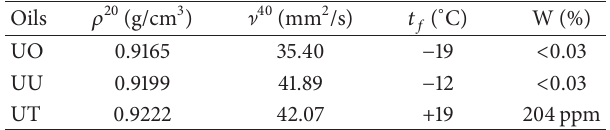
Table 2: Physicochemical properties of fresh, used, and treated oils. Oils